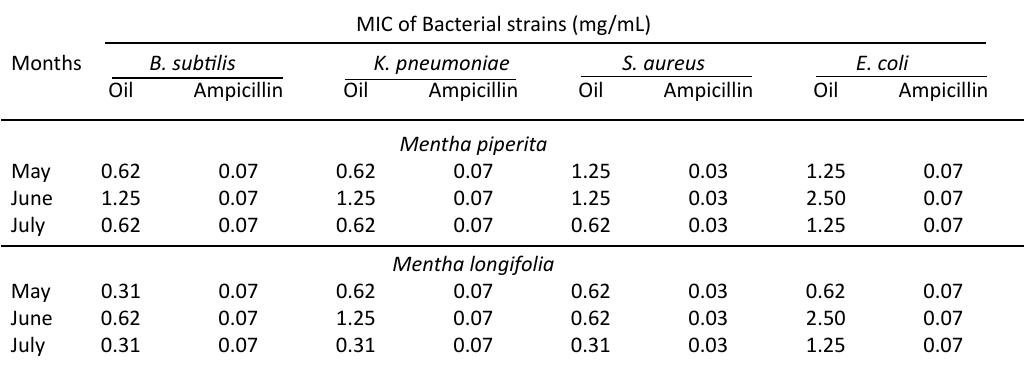
Table 4. Minimum inhibitory concentration (MIC) of M. piperita and M. longifolia leaves essential oil against B. subtilis, K. pneumoniae, S. aureus and E. coli MIC of Bacterial strains (mg/mL) Months B. subtilis Ampicillin